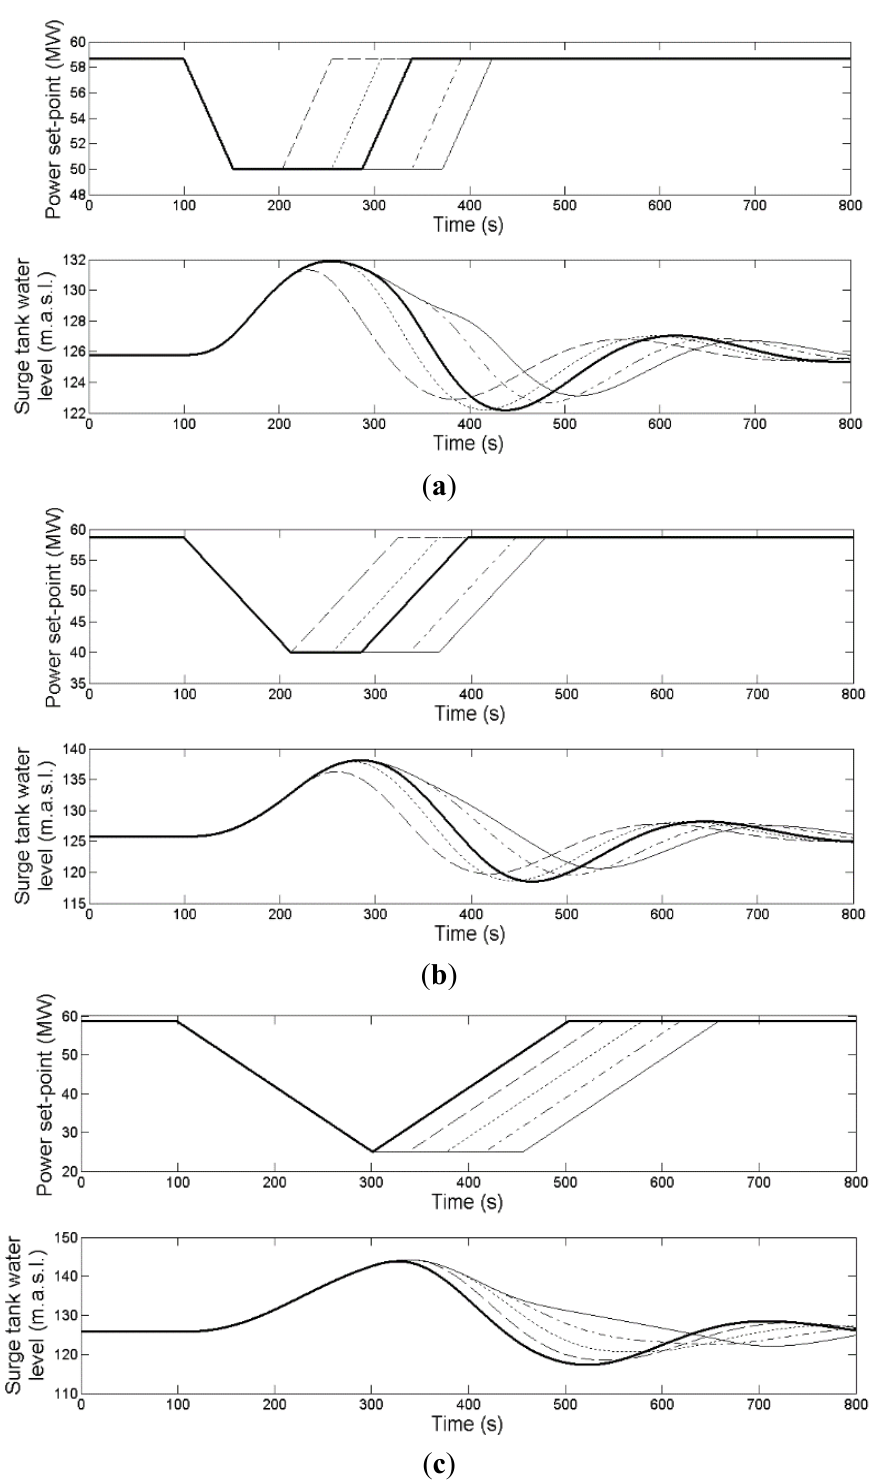
Figure 10. ( a ) Evolution of the surge tank water level in response to different sequences of down- and up-ward power set-point ramp signals with RD ≤ SOT/4; ( b ) evolution of the surge tank water level in response to different sequences of down- and up-ward power set-point ramp signals with SOT/4 < RD ≤ SOT/2; and ( c ) evolution of the surge tank water level in response to different sequences of down- and up-ward power set-point ramp signals with RD > SOT/2. RD: duration; SOT: period of the